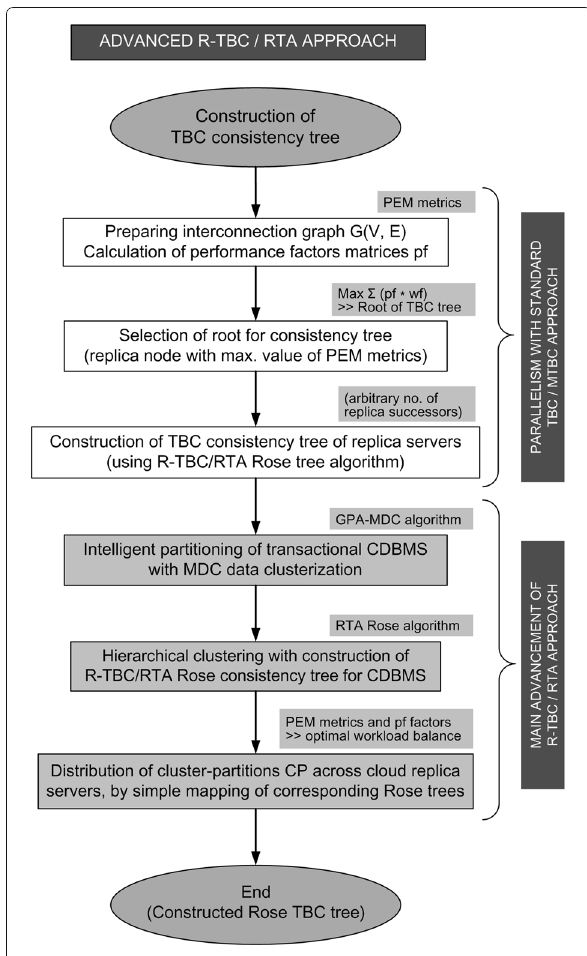
Fig. 5 Proposed advanced R-TBC/RTA approach and specific sequence of steps in the process of construction the R-TBC Rose Tree of consistency for a highly-distributed transactional database in a hybrid cloud